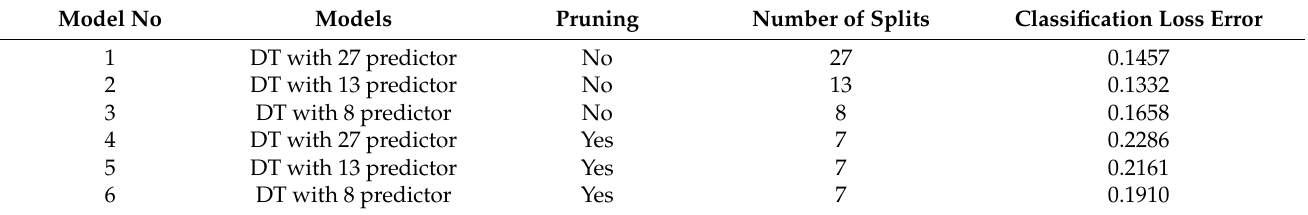
Table 6. The comparison of classification loss error values obtained from different DT